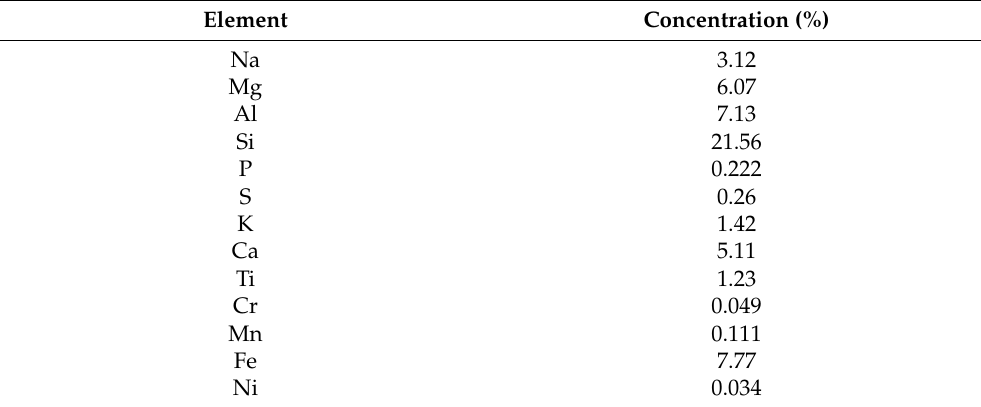
Table 3. The elemental concentrations in wt.% of calibration target for APXS in-situ calibration [22,25].